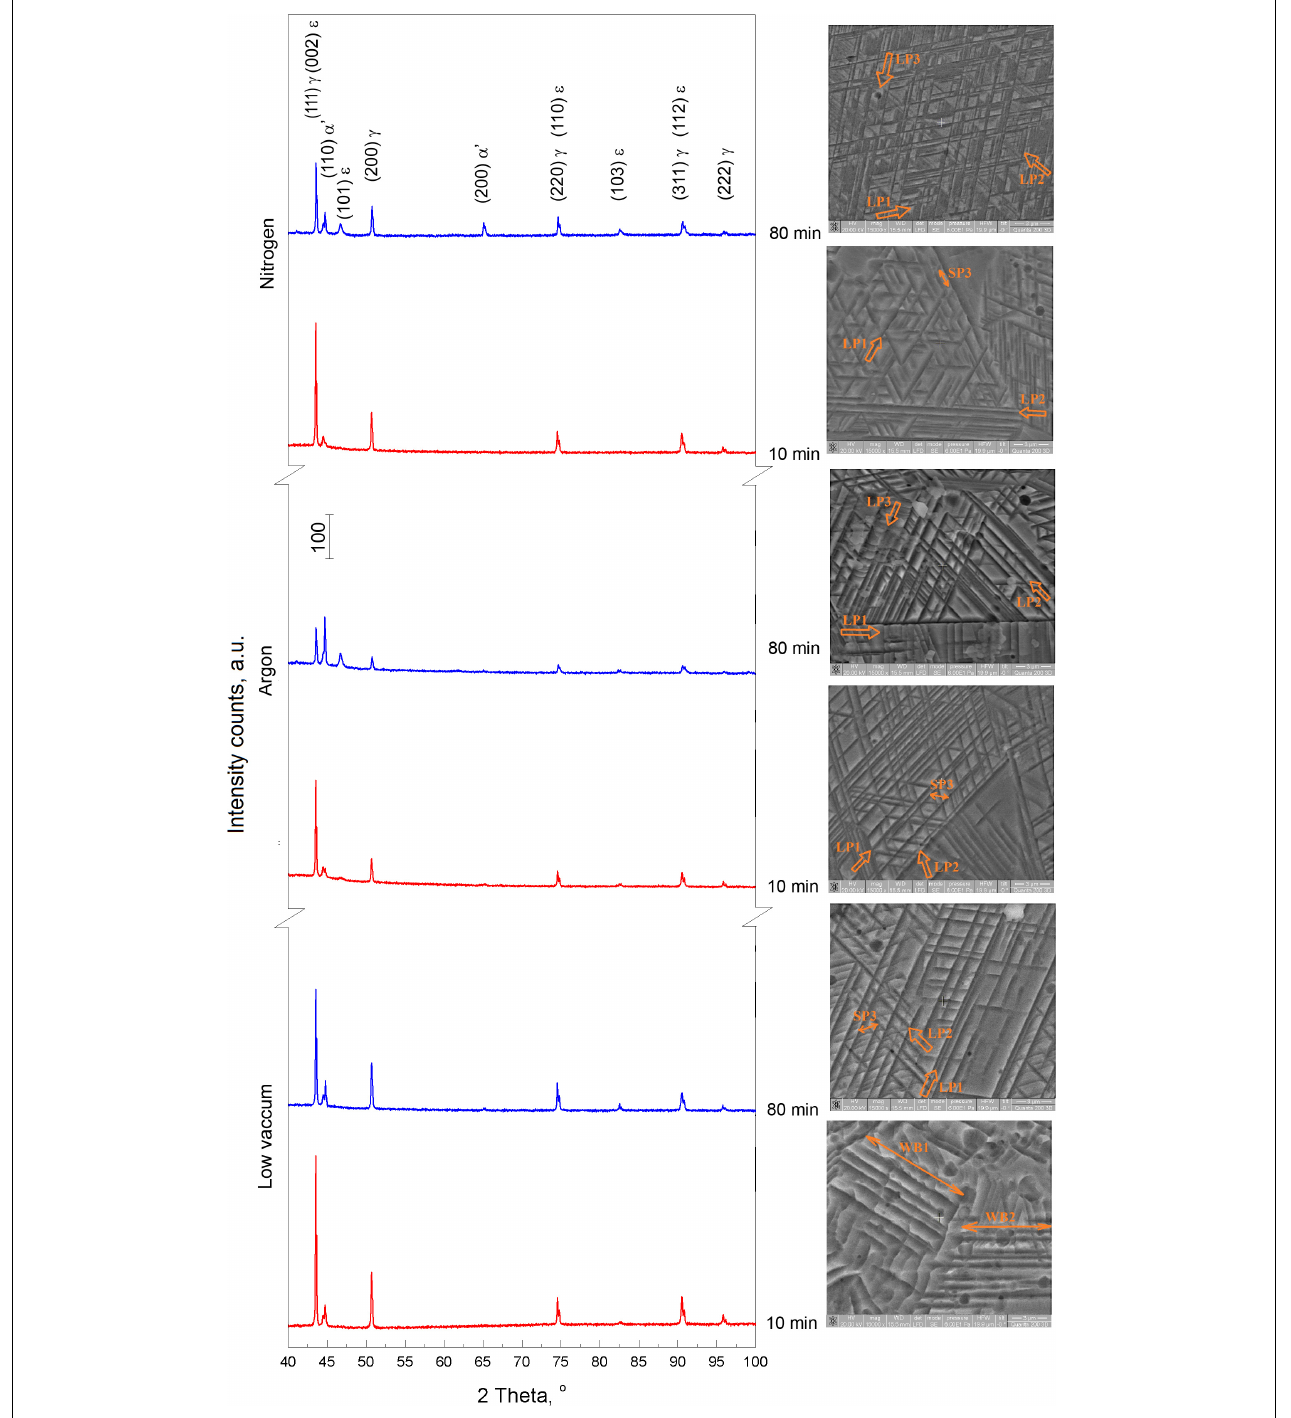
FIGURE 7 | Effects of holding environment (protective atmosphere: low vacuum, argon and nitrogen) and time (10, 80 min) on the structure of 50_MA specimens heat treated at 1,200 ◦ C (reproduced after Pricop et al., 2016, with permission granted by Springer